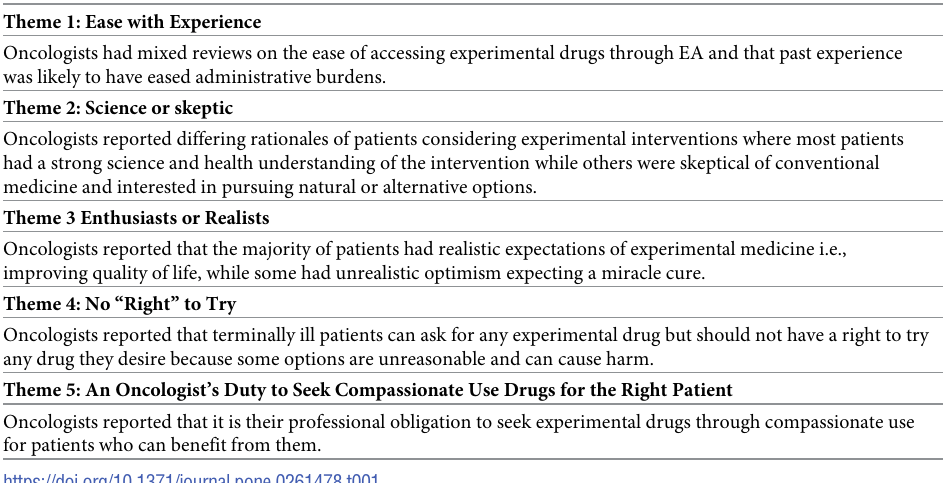
Table 1. Summary of themes. Theme 1: Ease with